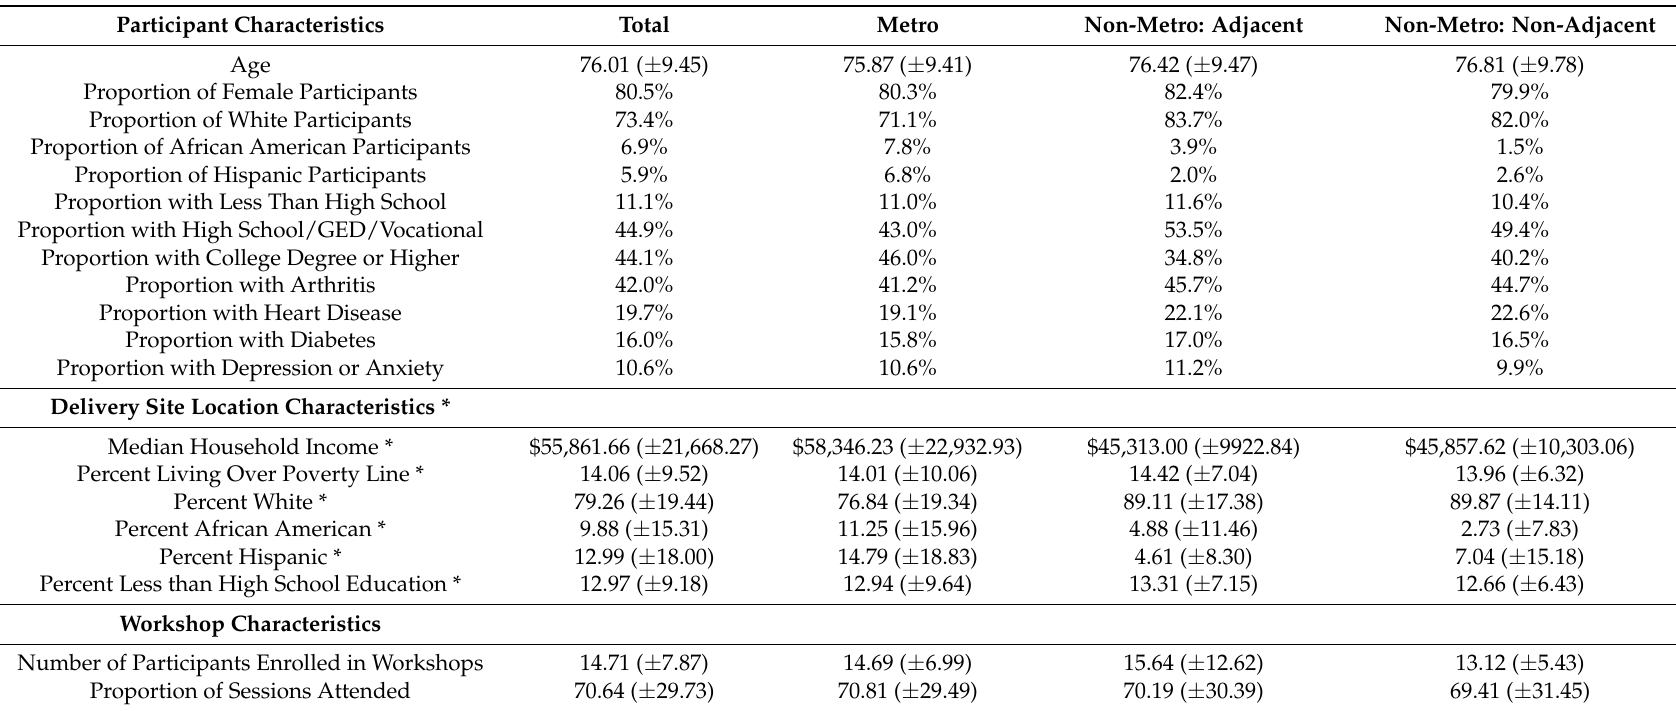
Table 3. Participant, Delivery Site Location, and Workshop Characteristics by